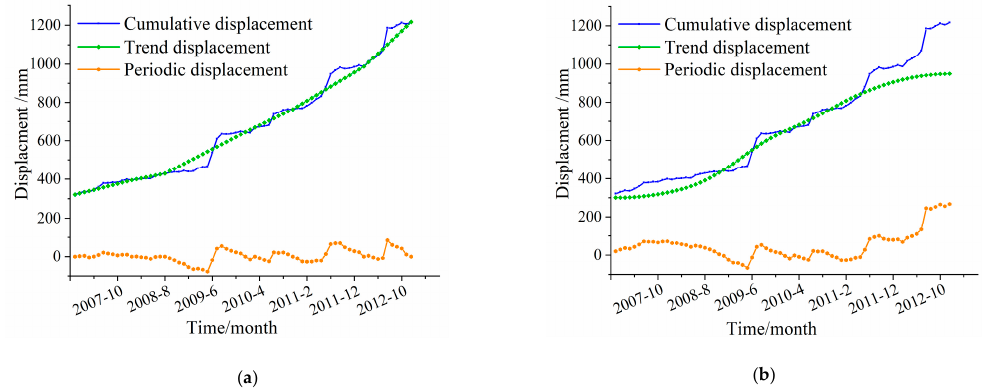
Figure 10. Comparison of decomposition results of landslide cumulative displacement by different methods. ( a ) DDM Difference decomposition method. ( b ) EMD decomposition method.